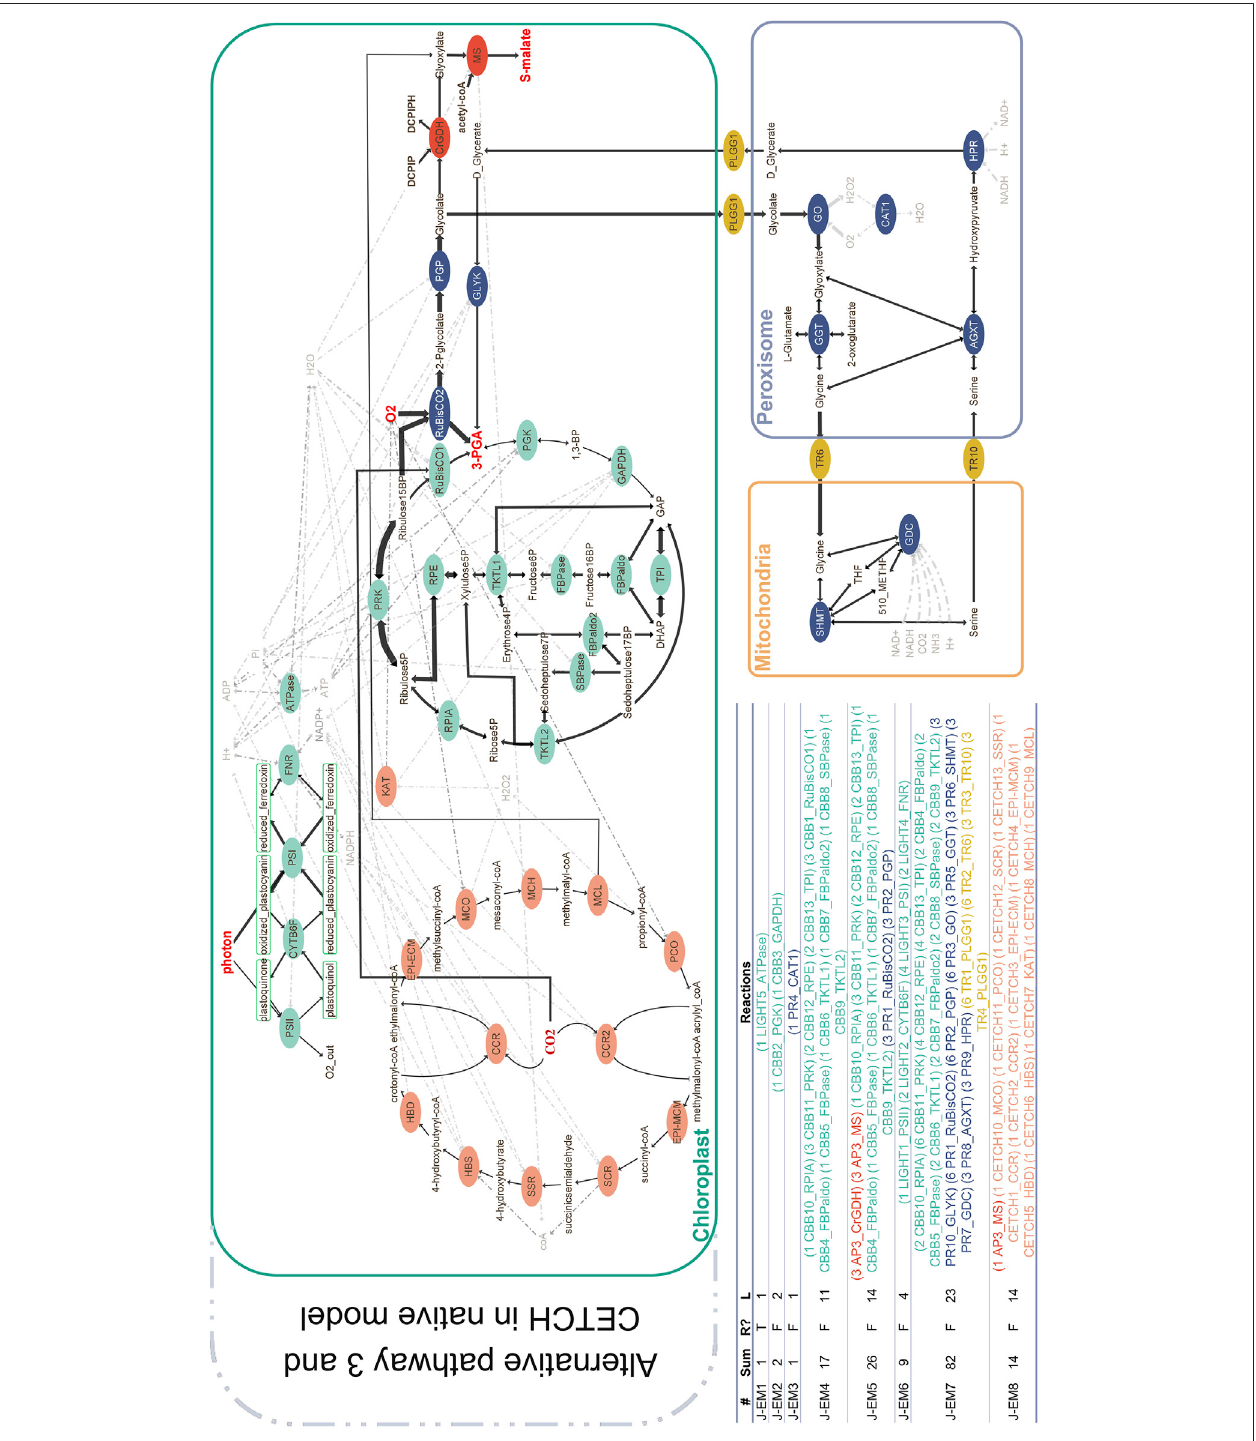
FIGURE 2 | AP3 (red) and CETCH cycle (orange) integrated in the native model of photosynthesis (green) and photorespiration (blue) with transporters between organelles (gold). The elementary modes are calculated according to reversibility and metabolite classi fi cation (internal/external). Reversible reactions are shown with double-sided arrows. Sum: fl ux sum, R: reversibility, L: length.